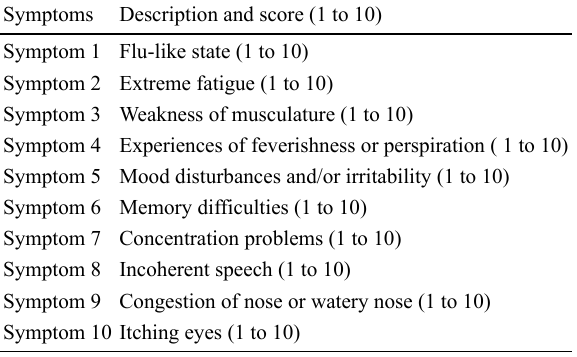
Table 2. Self-made POIS symptom